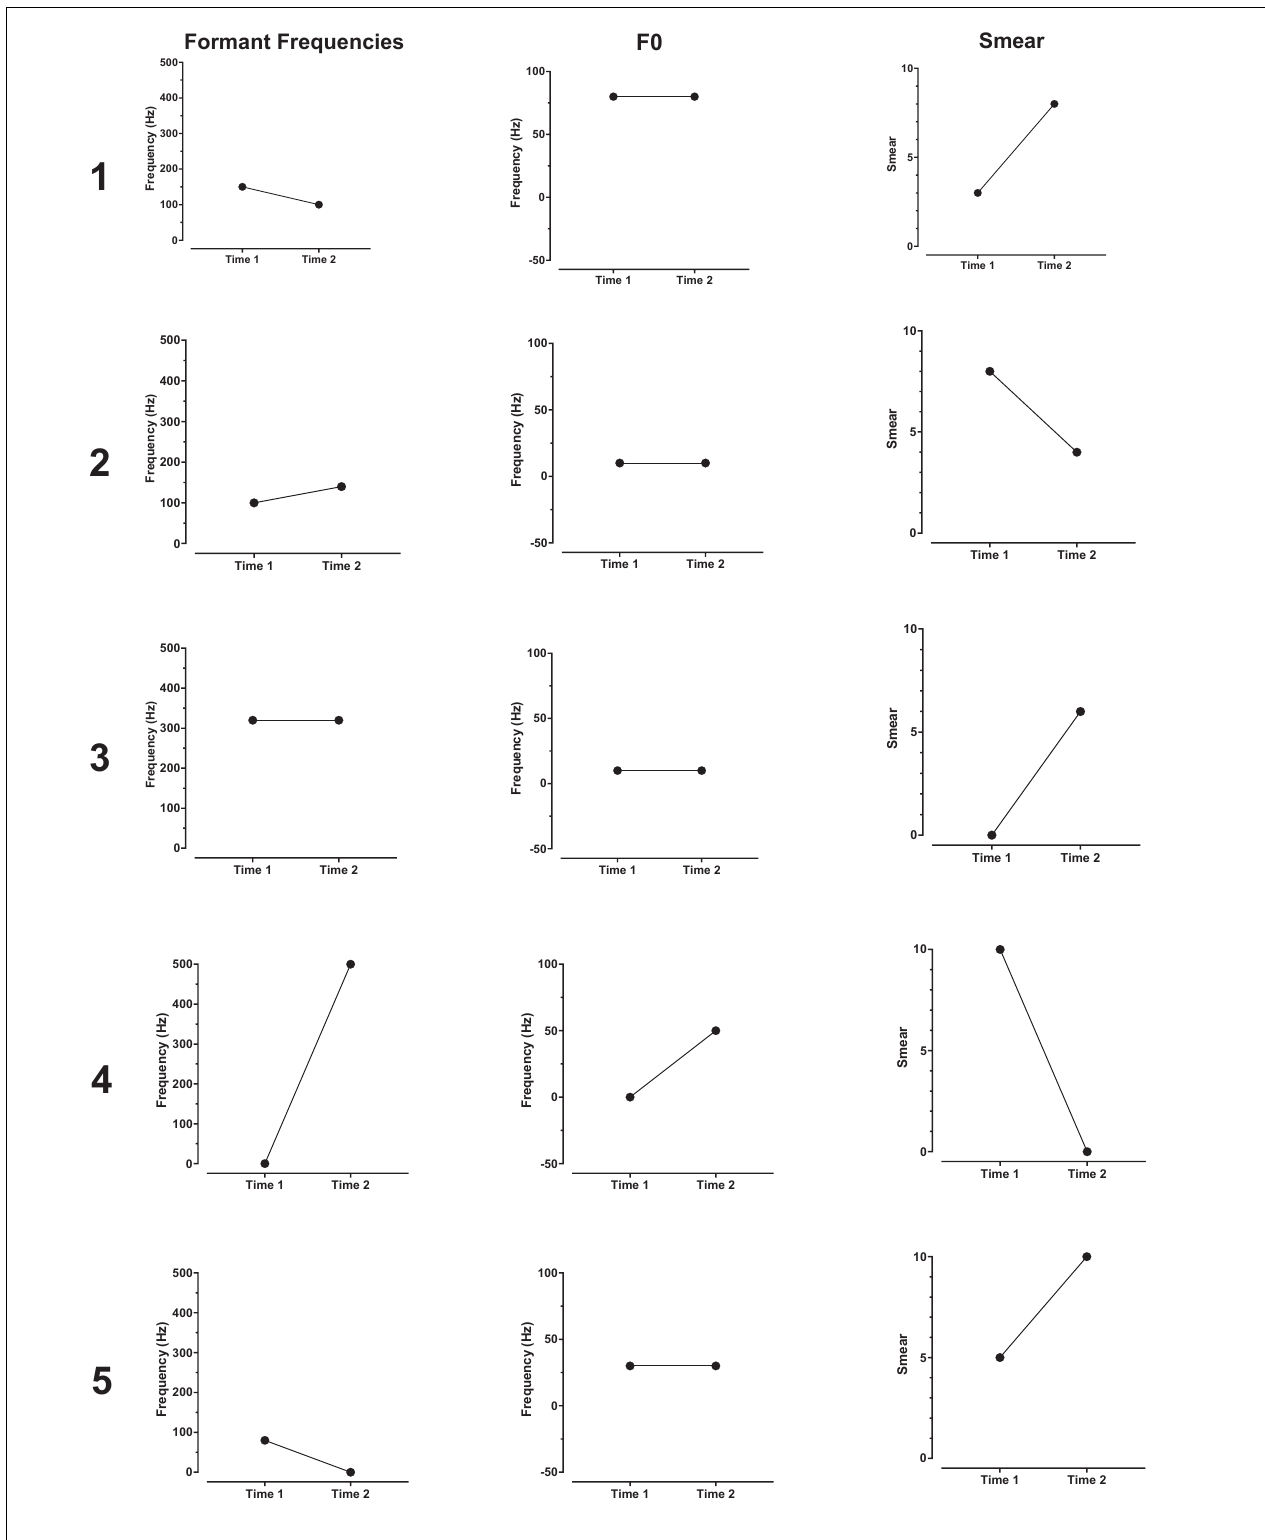
FIGURE 3 | Changes in formant frequencies, F0 and smear, relative to a clean signal, at Time 1 and Time 2. Numbers at the far left of each figure indicate patient number.